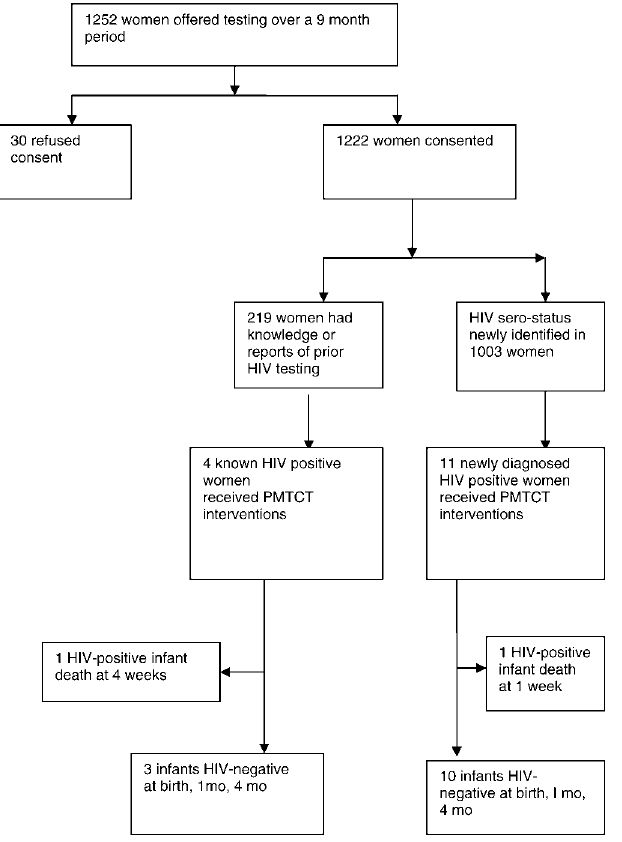
Figure 1. Flow of Participants Through the